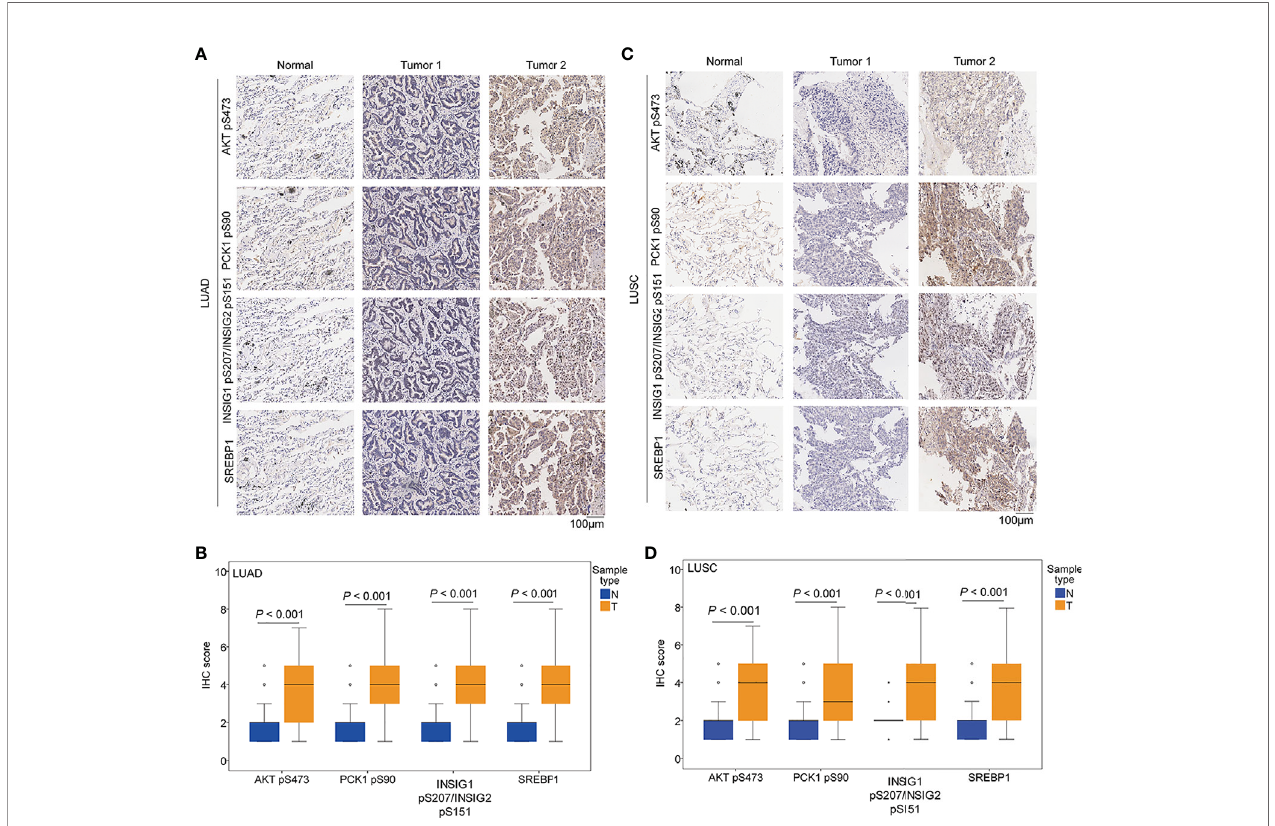
FIGURE 2 | The expression levels of AKT pS473, PCK1 pS90, INSIG1 pS207/INSIG2 pS151, and nuclear SREBP1 were upregulated in NSCLC specimens. IHC staining of 451 paired NSCLC specimens with their adjacent tissues was performed with the indicated speci fi city-validated antibodies. (A) Representative IHC staining of low and high levels of AKT pS473, PCK1 pS90, INSIG1 pS207/INSIG2 pS151, and nuclear SREBP1 expression in LUAD tissues and normal tissues. (B) Expression levels of AKT pS473, PCK1 pS90, INSIG1 pS207/INSIG2 pS151, and nuclear SREBP1 in LUAD tissues (n = 306) and normal tissues (n = 302). (C) Representative IHC staining of low and high expression levels of AKT pS473, PCK1 pS90, INSIG1 pS207/INSIG2 pS151, and nuclear SREBP1 in LUSC tissues and normal tissues. (D) Expression levels of AKT pS473, PCK1 pS90, INSIG1 pS207/INSIG2 pS151, and nuclear SREBP1 in LUSC tissues (n = 145) and normal tissues (n =